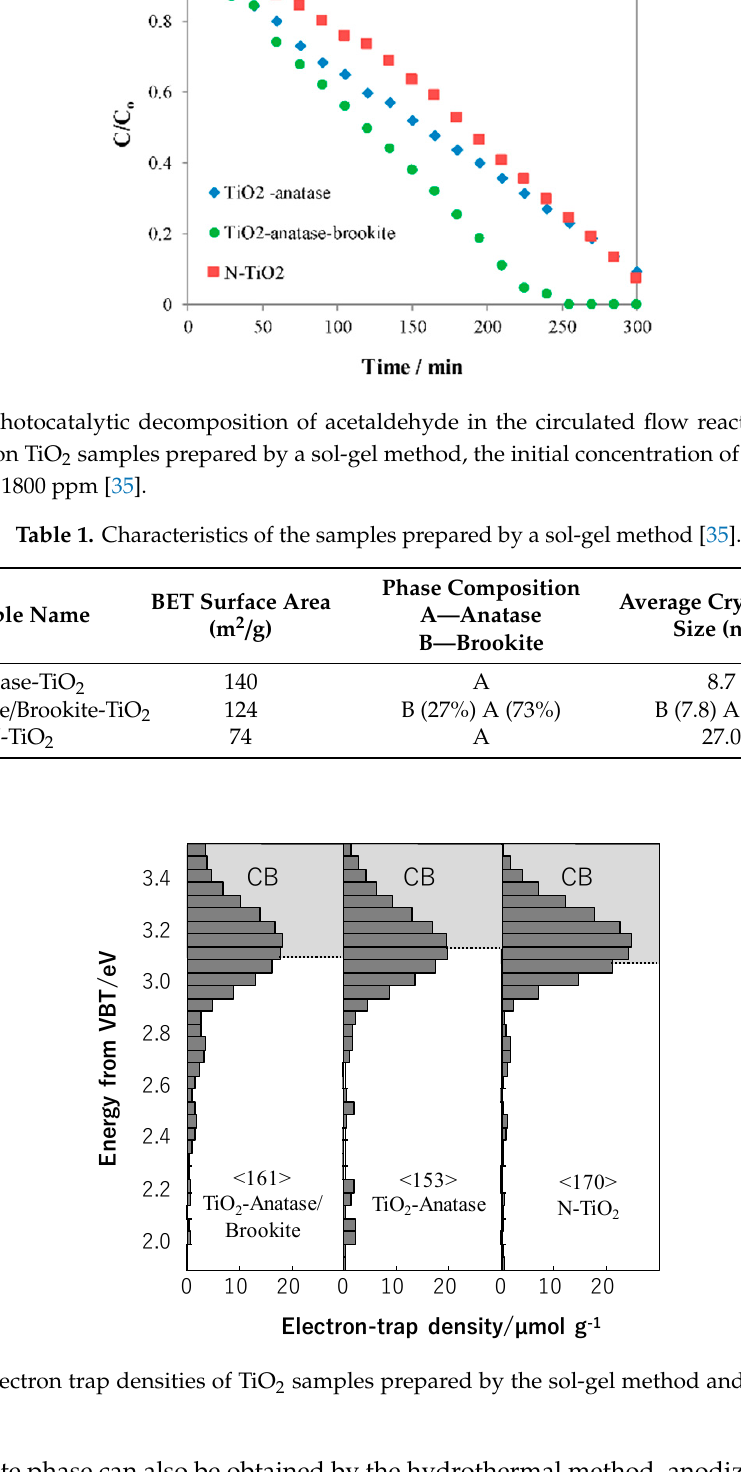
Figure 7. Electron trap densities of TiO 2 samples prepared by the sol-gel method and calcinated at 400 °C [35]. N-TiO 2 revealed higher density of electron traps than TiO 2 consisting of mixed phases of anatase and brookite, however its photocatalytic activity towards acetaldehyde decomposition was lower. The reason for that was formation of Ti 3+ centers and oxygen vacancies in N-TiO 2 , which were detrimental for acetaldehyde decomposition [35]. The most probable at the presence of oxygen